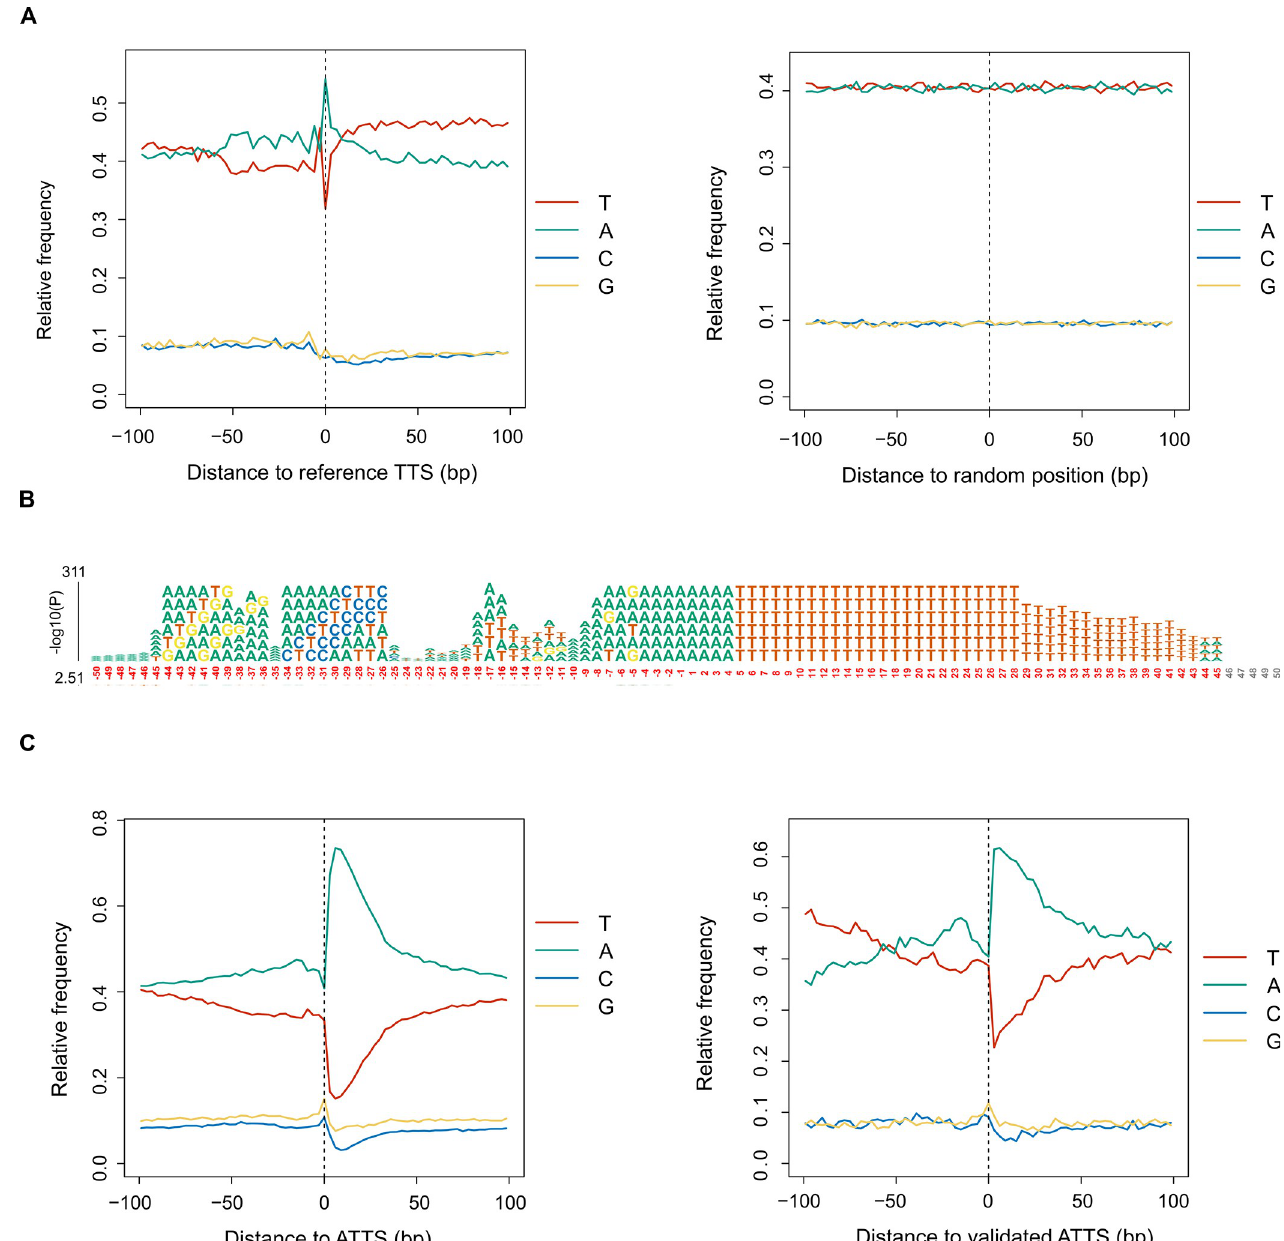
Fig 4. Analysis of transcript 3 0 ends. Genomic sequence analysis was performed for selected positions from the Plasmodium falciparum 3D7 v3.2 reference genome [14]. (A) Average base composition of genome sequence flanking 100 bp on either side of reference transcript termination sites (TTS; 5,560 positions) and 5,560 randomly selected positions (right). (B) Over-represented 6-mer motifs identified by kpLogo analysis [36] comparing sequences flanking reference TTS with control random positions. Complete tabulated results from kpLogo analysis are shown in S4 Table. (C) Average base composition of genome sequence flanking 100 bp on either side of all alternative transcript termination sites (ATTS) for novel isoforms (10,753 positions) and ATTS validated by direct RNA sequencing data (943